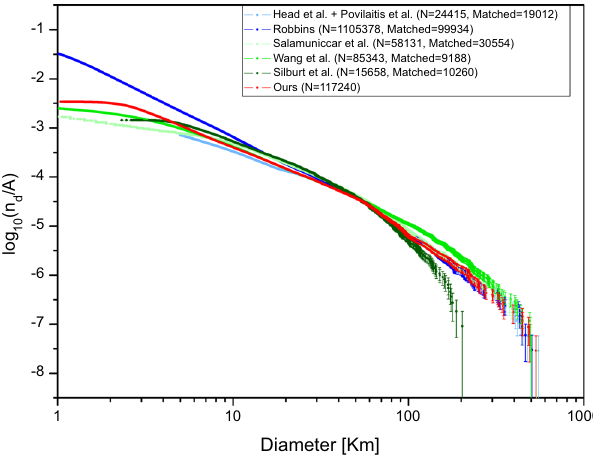
Fig. 4 The cumulative size-frequency distributions (CSFDs) of craters in the existing databases and those identi fi ed in this paper. The light blue and blue lines show the crater CSFDs of the manual lunar crater databases, i.e., combined Head et al. + Povilaitis et al. and Robbins. The light green, green and dark green lines show CSFDs of the three automated crater catalogues, i.e., Salamuni ć car et al., Wang et al. and Silburt et al. The red line represents the CSFD of the craters identi fi ed in this paper. The con fi dence interval ± σ , which for the k th crater is log k ± is the surface area, k th crater means that the k th-largest crater at the level of diameter. Source data are provided as a source data fi